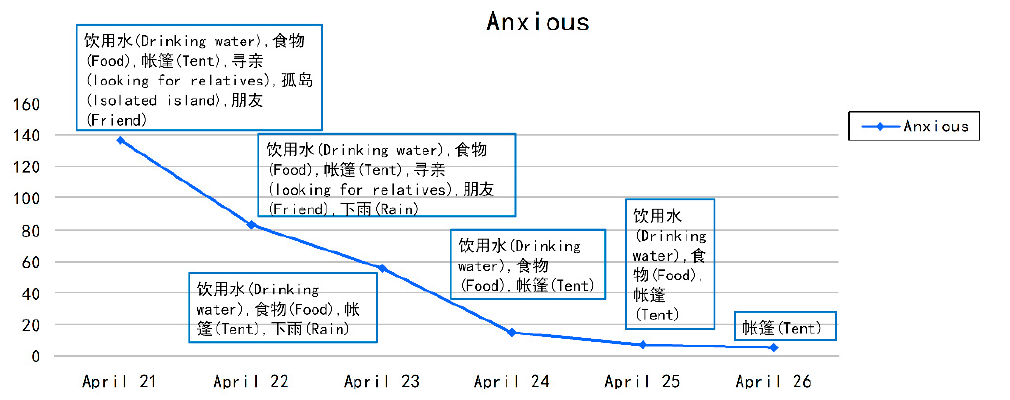
Figure 9. Sequence diagram of positive emotion (the words in the text box are the hot words related to this emotion in the corresponding time period).